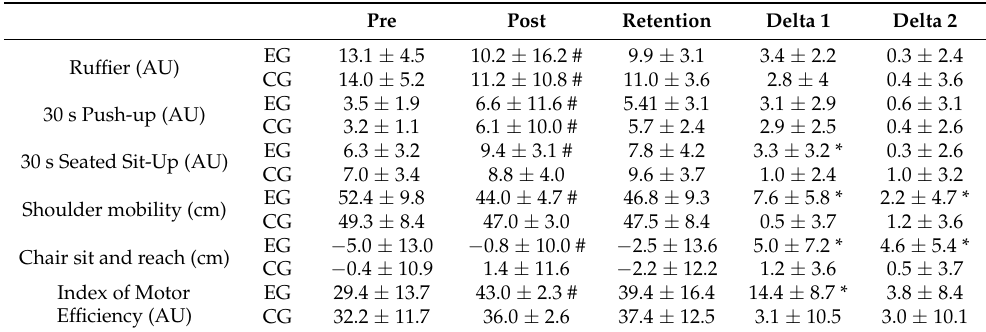
Table 1. Results of CFT test performed before the intervention (pre), at the end of the intervention (post) and 4 weeks after the end of the intervention